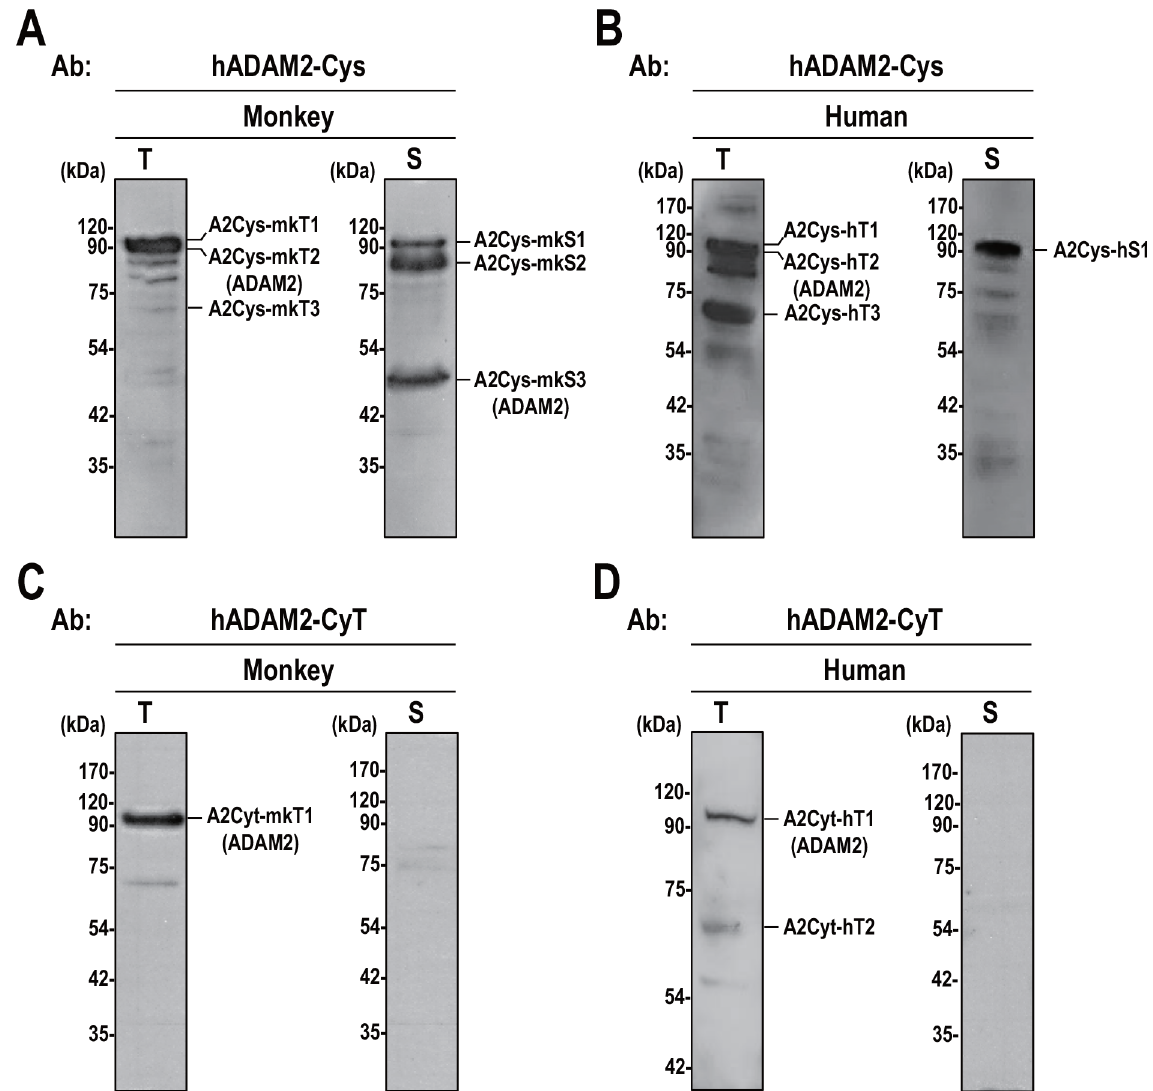
Fig 5. Expression of ADAM2 in monkey and human germ cells. A and B . Extracts of testicular cells and sperm from A . monkeys and B . humans were subjected to SDS-PAGE, and blotted with anti-hADAM2-Cys. C and D . Lysates from C monkey and D human germ cells were immunoblotted with anti-hADAM2-CyT. Experiments were repeated three times. Reduced protein samples were subjected to SDS-PAGE using 10% resolving gels. Abbreviation: T, testicular cells; S, sperm; and β -ME, β -mercaptoethanol. Molecular masses are presented on the